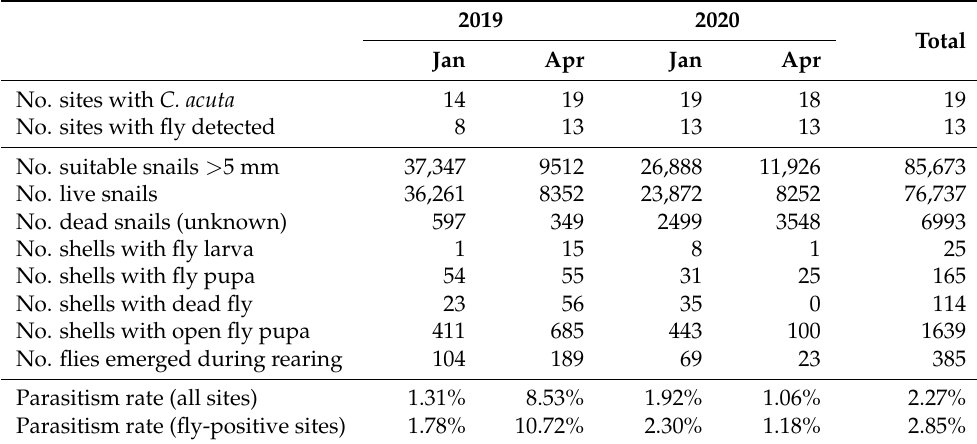
Table 1. Parasitism by S. villeneuveana of C. acuta on Yorke Peninsula, South Australia, in January and April of 2019 and 2020.